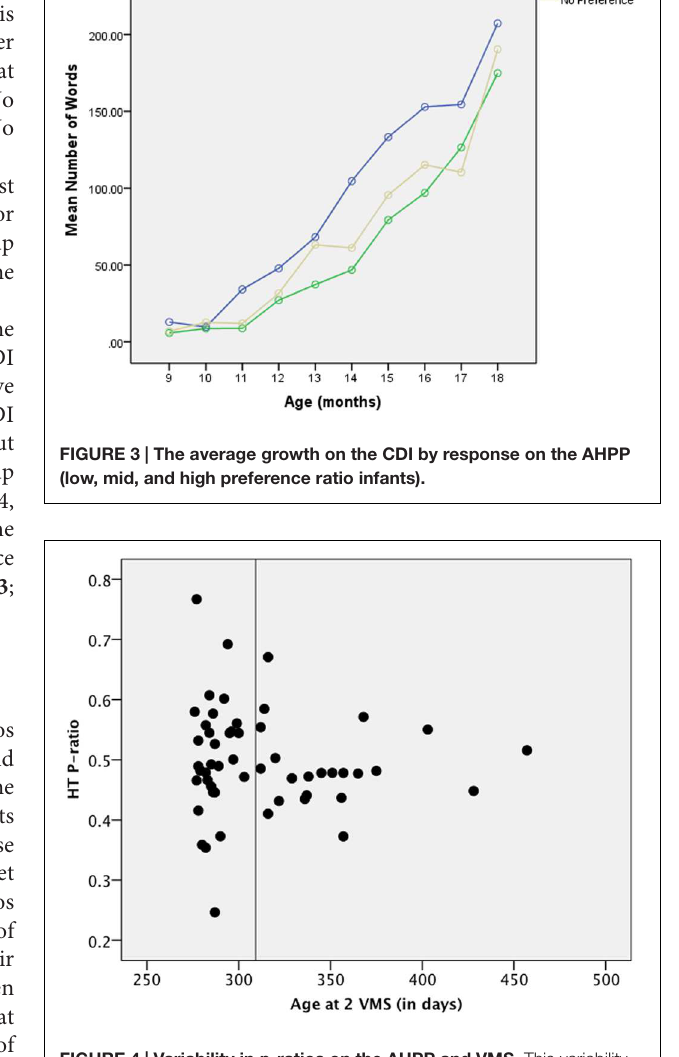
FIGURE 4 | Variability in p -ratios on the AHPP and VMS. This variability reflects differences between infants who had versus had not attained two VMS by the test date. The vertical line represents the AHPP test date of 10 months. Infants to the left of the line had acquired two VMS by the AHPP test, while those to the right had